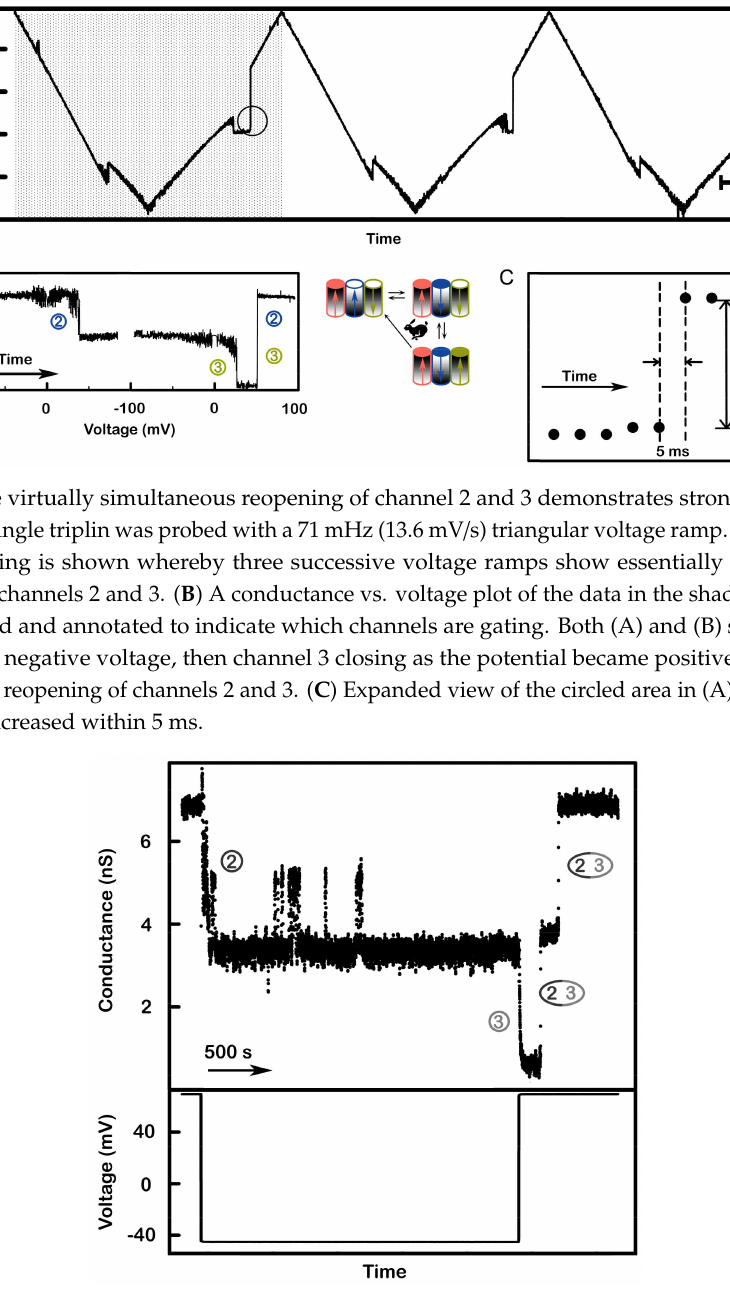
Figure 9. Model tested by voltage pulse sequence. This membrane contained two conducting triplins (total conductance a little over the expected 6 nS due to a small background conductance). First the voltage was stepped from + 69 to − 45 mV in order to close the two channel 2. A rapid drop in conductance ( < 47 ms) of ~3.4 nS was observed, consistent with about two channel 2 closures. Then the voltage was stepped back to + 69 mV to close channel 3 before channel 2 could reopen. An immediate decrement of conductance from 3.3 to 0.5 nS was seen, indicating the closure of two channel 3. Soon after the drop, two increments, each of about 3 nS, were detected. This was interpreted to be two synchronized reopenings of channels 2 and 3. This recording is typical of many